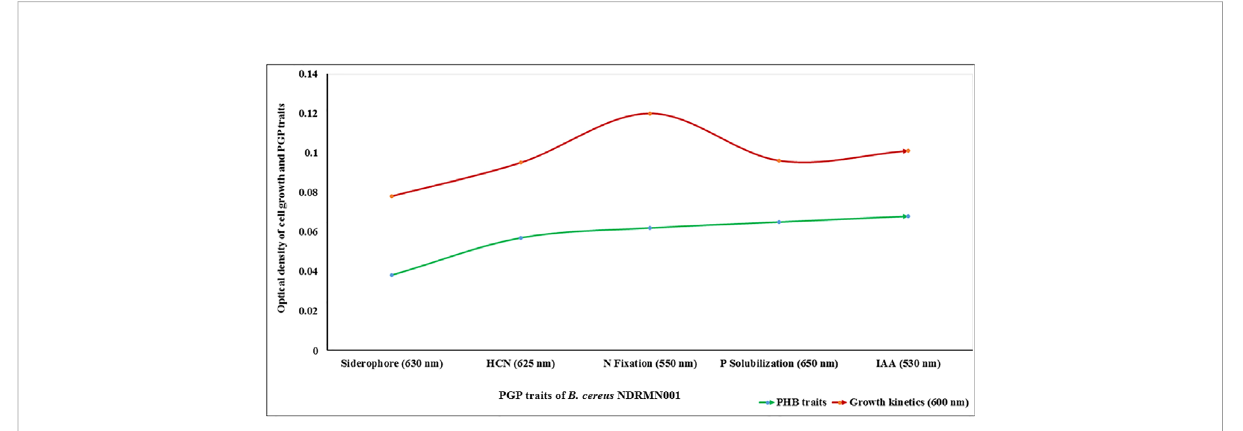
FIGURE 2 Quantitative analyses of PGP traits of B. cereus